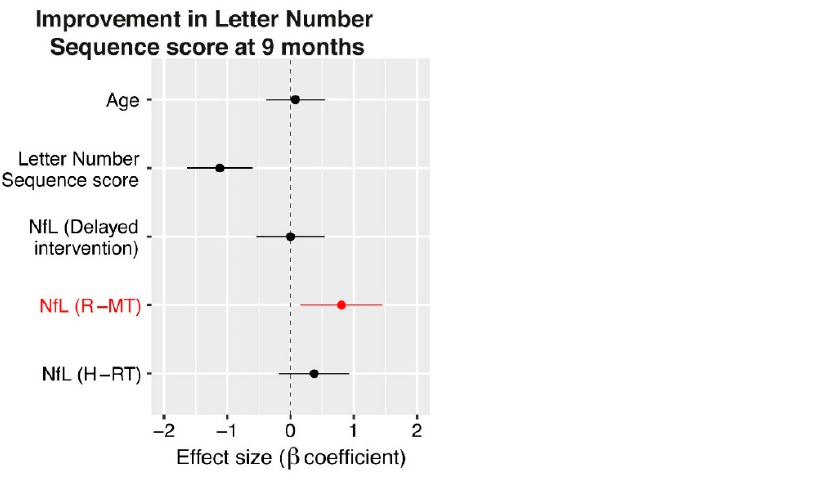
Figure 1. Blood neurofilament light chain (NfL) levels predict functional improvement in the late phase after stroke. In the cognitive domain, but not for balance and gait, the predictive value of elevated blood NfL levels was dependent on the type of intervention. ( A ) Forest plots showing estimated standardized coefficients and their 95% confidence interval for the predictors in fully adjusted logistic regression analysis, modelling functional improvement in balance, ( B ) gait and ( C ) cognition as a measure of the relative importance of each variable. NIHSS, NIH Stroke Scale. R-MT, rhythm- and music-based therapy; H-RT, horse-riding therapy. Study participants in the delayed intervention group did not receive any rehabilitation during the clinical trial but were offered rhythm- and music-based therapy after study completion. Reproduced from [31] under CC BY-NC 4.0.